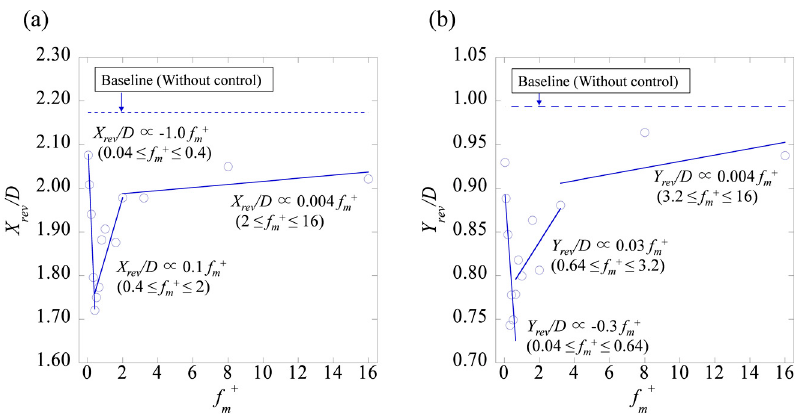
Figure 11. The lengths of the recirculation region (model wake) as a function of f m + : ( a ) the length X rev / D and ( b ) the width Y rev / D .